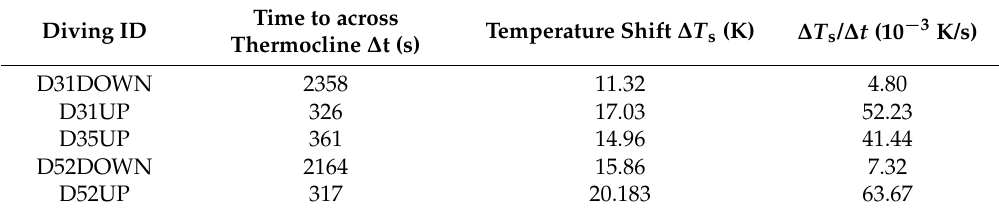
Table 2. Information of profile measurement